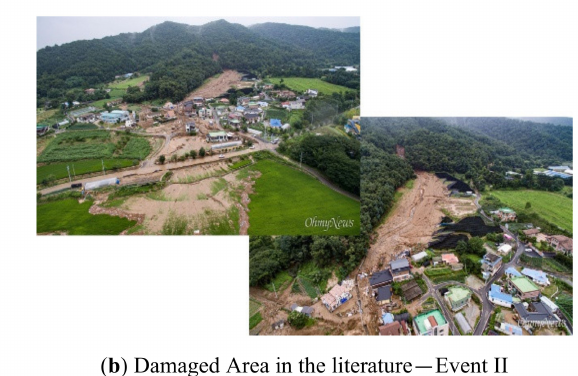
Figure 15. Results of RAMMS using HQPF—Event III. ( a – c ) are the Max Height (m), Max Pressure (kPa), and Max Velocity (m/s) in the modeling results of the debris flow in Sungduk Village, respectively.